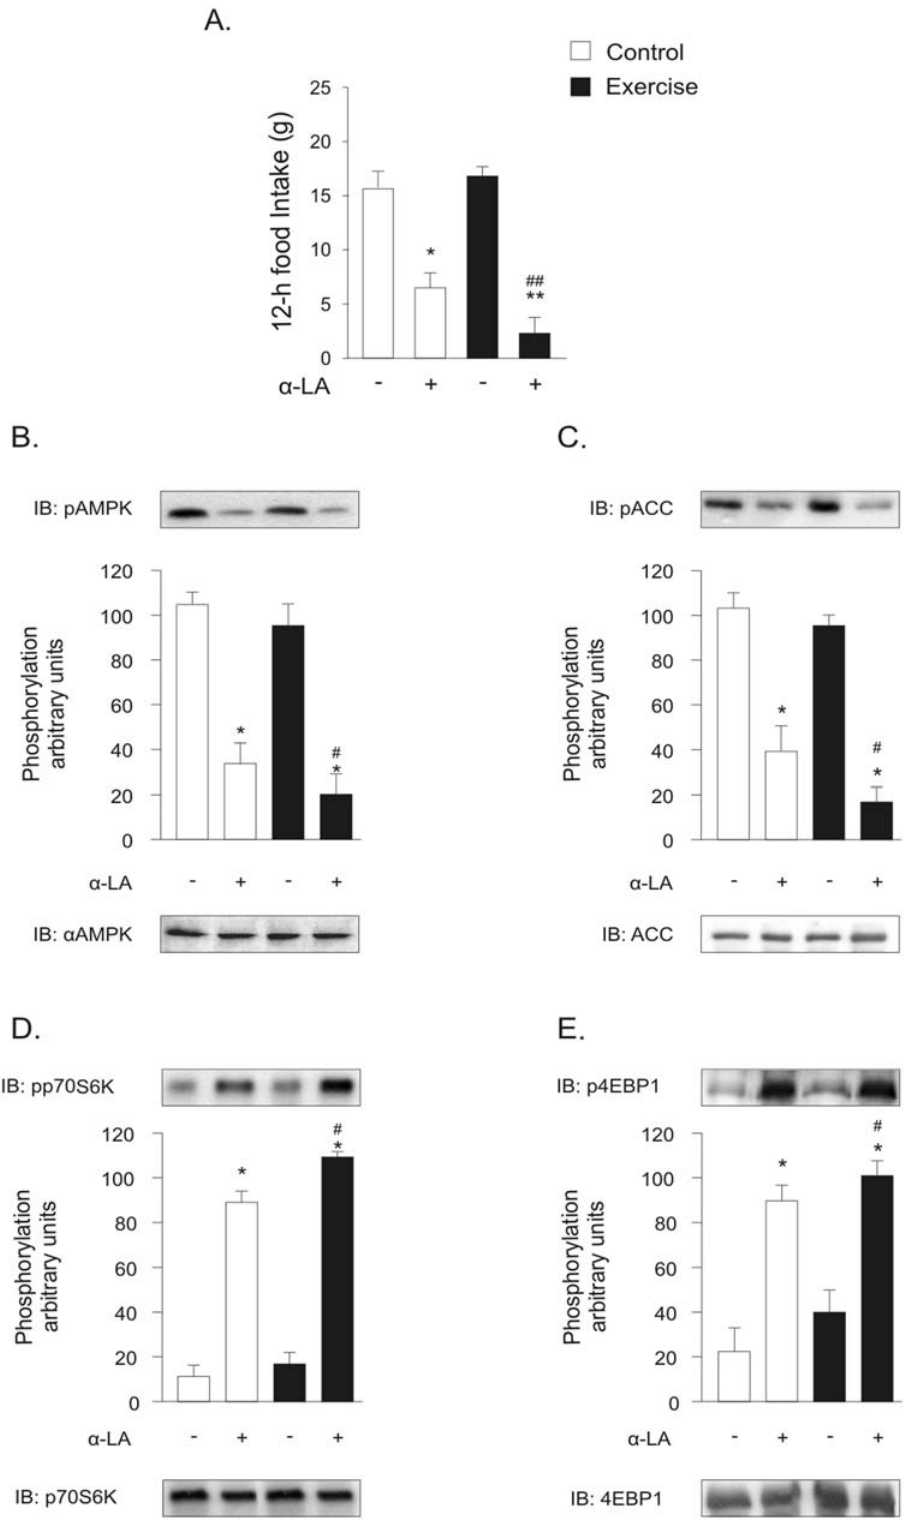
Figure 4. a -LA effects on 12-h cumulative food intake and AMPK/mTOR signaling, in the hypothalami of control and exercised rats. (a) a -LA (3 m g) was administered in control and exercised rats. Animals were immediately exposed to food for a 12-hour period ( n =8–10 animals per group). (b, c, d, e) Representative Western blots of four independent experiments showing hypothalamic lysates from Wistar rats. Phospho- AMPK thr172 , threonine-phosphorylated AMPK and total AMPK (b); phospho-ACC ser79 , serine phosphorylated ACC and total ACC (c); phospho- p70S6Kinase thr389 , threonine phosphorylated p70S6Kinase and total p70S6K (d); phospho-4EBP1 thr70 , threonine phosphorylated 4EBP1 and total 4EBP1 (e). Data are the means 6 SEM. * p , 0.05, vs. control group; # p , 0.05, vs. exercised non-stimulated group.